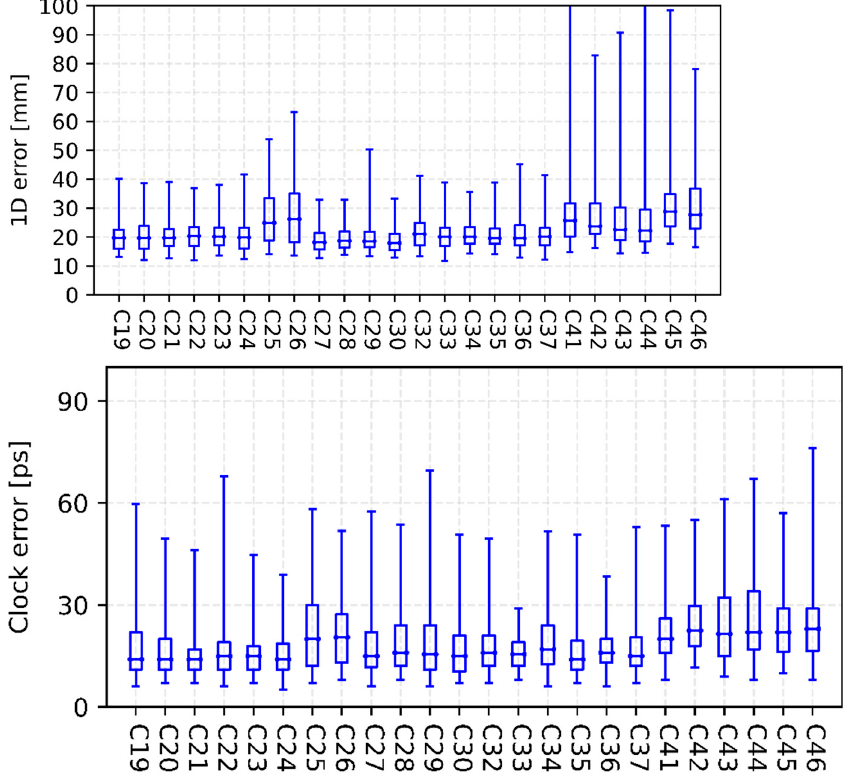
Figure 5. Internal precision of iGMAS final combined BDS-3 MEO orbit ( top panel ) and clock ( bottom panel ).